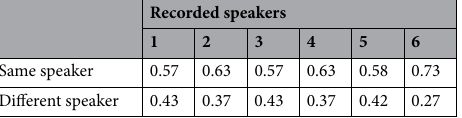
Table 7. Frequencies of speaker ratings in Experiment 2 separated by speakers of the stimuli.